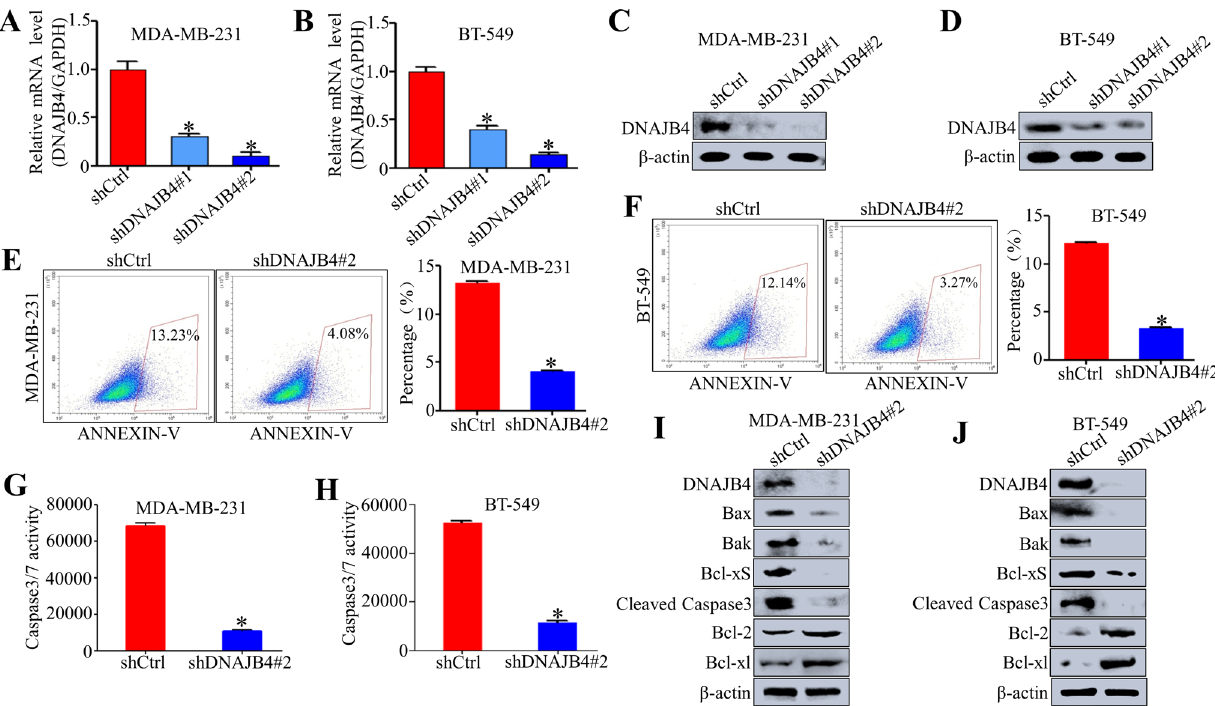
Fig. 2 Knockdown of DNAJB4 inhibits TNBC cell apoptosis in vitro. A , B Relative DNAJB4 mRNA expression in MDA-MB-231 and BT-549 cells expressing shDNAJB4 #1 and shDNAJB4 #2 analyzed by qRT-PCR. Experiments were conducted in triplicate. Bar graph data are presented as the mean ± SEM; *, P < 0.05. C , D Western blot analysis of DNAJB4 expression in DNAJB4-silenced MDA-MB-231 and DNAJB4-silenced BT-549 cells. β-actin was used as a loading control. E , F Flow cytometry assay was used to detect the effect of cell apoptosis in DNAJB4-silenced MDA-MB-231 and DNAJB4-silenced BT-549 cells. Representative profiles are shown on the left, and the percentage of cells was statistically analyzed on the right. Experiments were conducted in triplicate. Bar graph data are presented as the mean ± SEM; *, P < 0.05. G , H The apop- tosis level of DNAJB4-silenced MDA-MB-231 and DNAJB4-silenced BT-549 cells were detected by Caspase3/7 activity kit. Experiments were conducted in triplicate. Bar graph data are presented as the mean ± SEM; *, P < 0.05. I , J Western blot analysis of the expression level of cru- cial cell apoptosis regulatory proteins in DNAJB4-silenced MDA-MB-231 and DNAJB4-silenced BT-549 cells. β-actin was used as loading con-